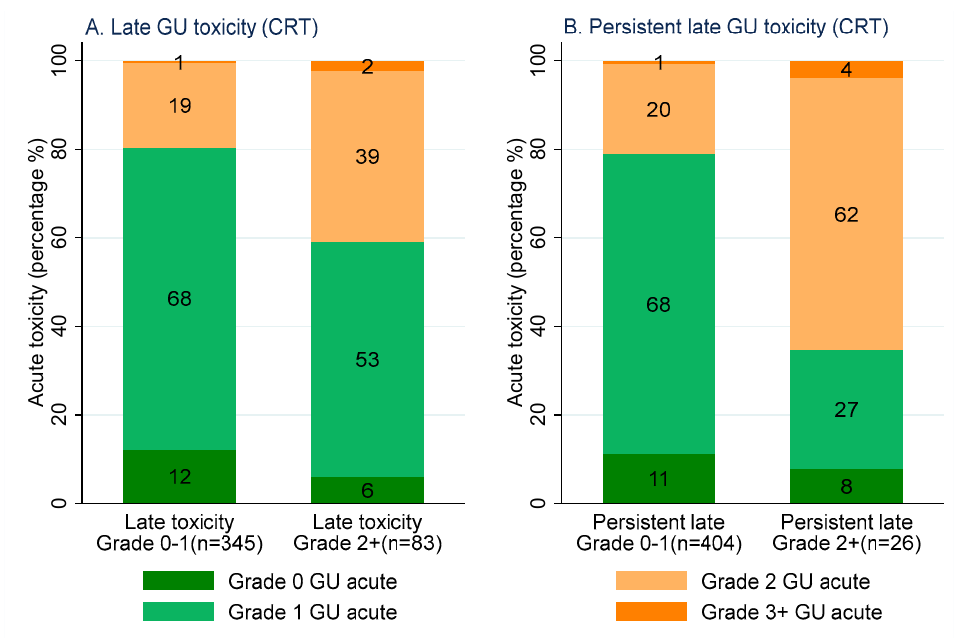
Figure 2. Stacked bar graph: maximum grade CTCAE acute GU toxicity experienced for patients with Grade 0–1 (left of each figure) and Grade 2+ (right of each figure) late GU toxicity following CRT ( left ). Maximum grade CTCAE acute GU toxicity experienced by patients with grade 0–1 (left of each figure) and grade 2+ (right of each figure) persistent late GU toxicity following CRT ( right ).